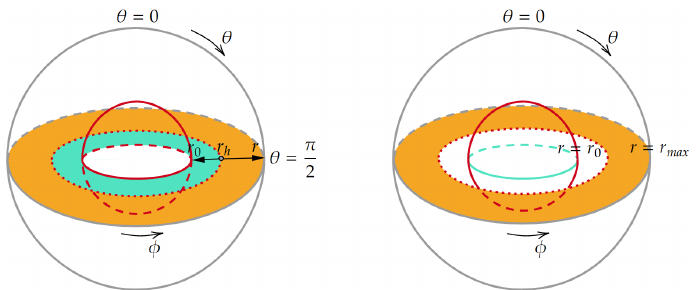
in t = 0 slice. Right: Island calculation 2